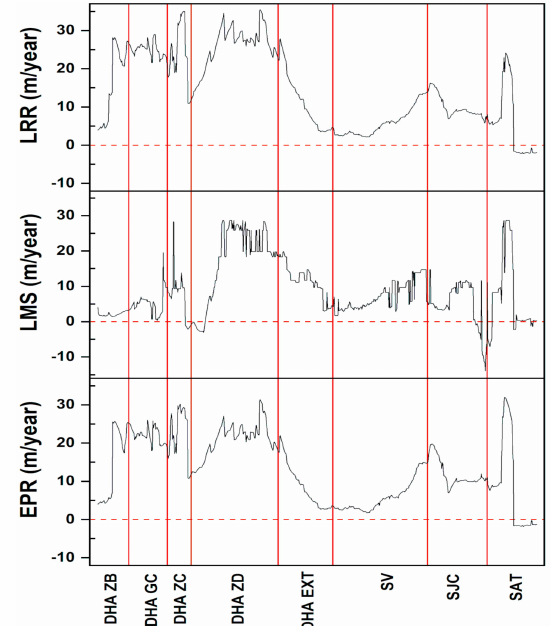
Figure 5. Shoreline change rate (EPR, LMS, LRR) of eastern zone (DHA = Defense housing Authority; ZB = Zone B; GC = Golf Club; ZC = Zone C; Ext = Extension, SV = Sea-view, SJC = Shireen Jinnah Colony, SAT = South Asian